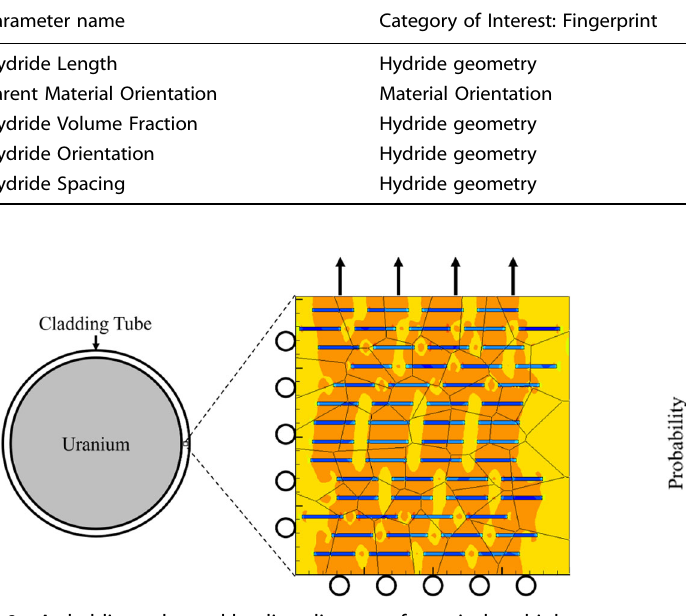
Fig. 3 A cladding tube and loading diagram of a typical multiphase hydrided zirconium alloy representative volume element. Table 3. Material Properties.